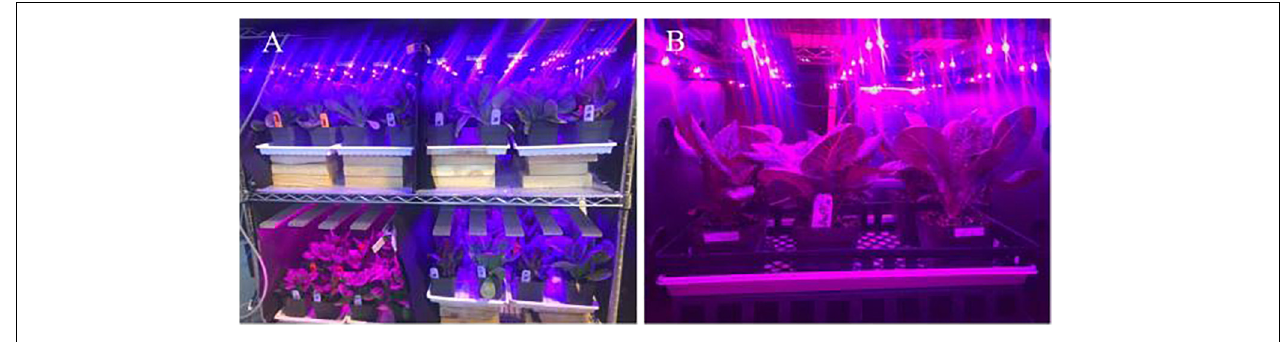
FIGURE 1 | (A) Experimental setup used in the study showing different experimental units. (B) A closeup picture of one experimental unit. TABLE 1 | Total light intensity (400–750 nm), phytochrome photostationary state (PSS), and spectral composition of light in different treatments. Treatment Intensity PSS Spectral